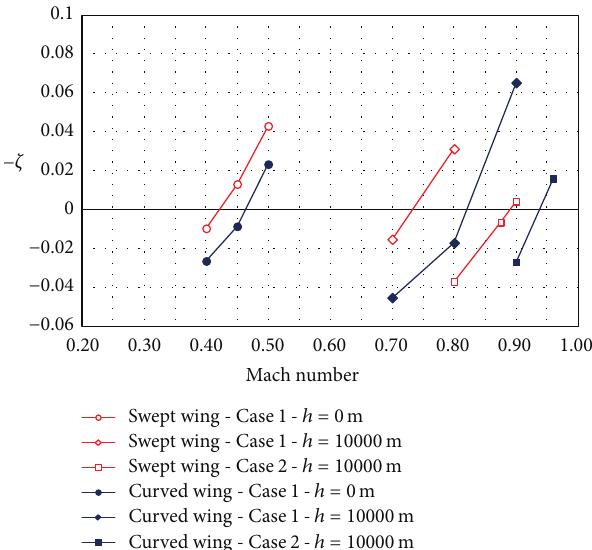
Figure 15: Damping ratio versus Mach (the damping data are represented with the opposite sign).